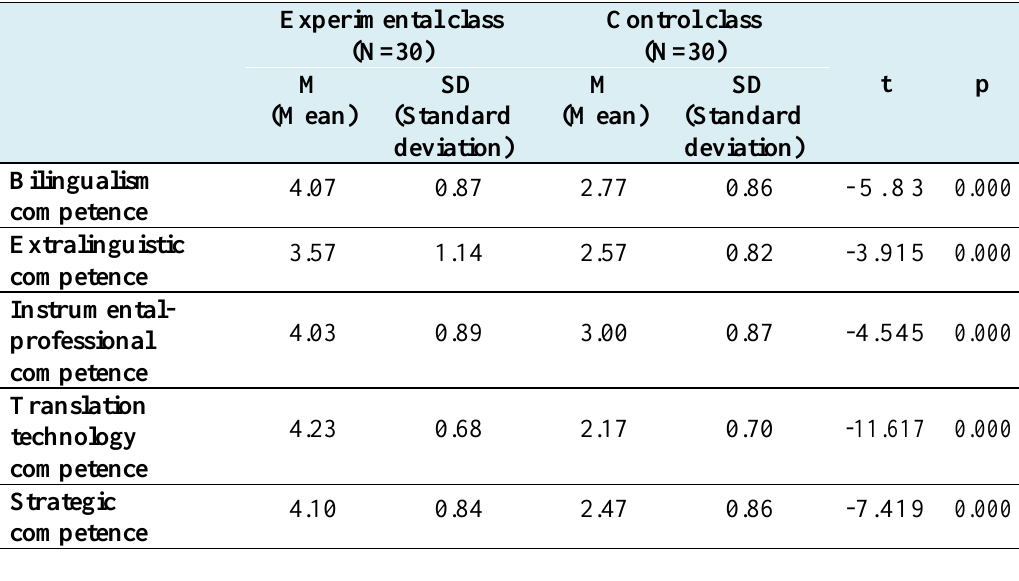
Comparison of scores on pre- and post- translation tests of the experimental class and the control